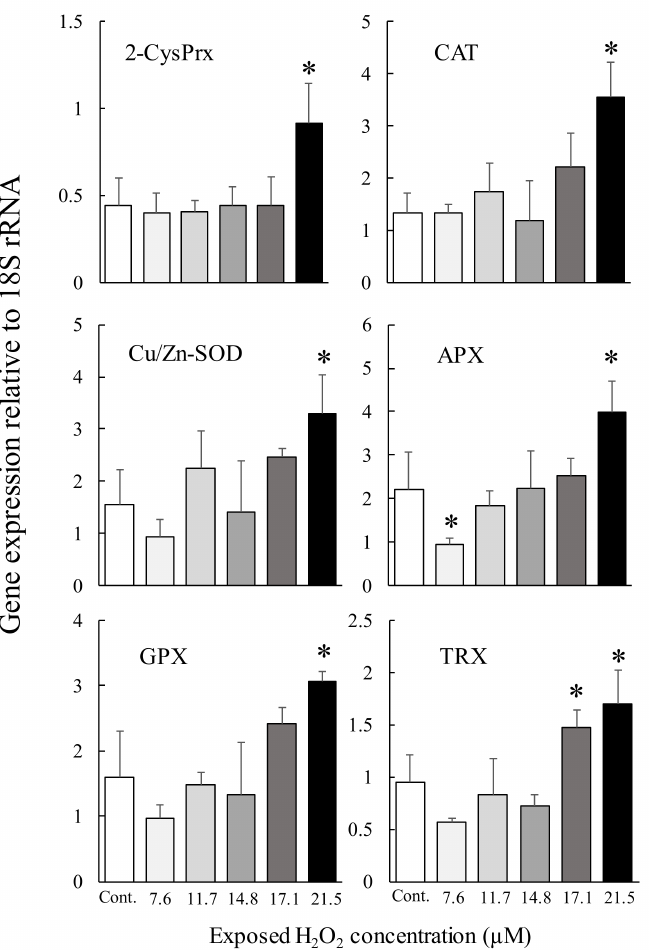
Figure 5. Levels of gene expression of six antioxidant enzymes (2-CysPRX, Cu Zn superoxide dismutase (Cu/Zn-SOD), glutathione peroxidase (GPX), catalase (CAT), ascorbate peroxidase (APX), and thioredoxin (TRX)) determined by quantitative PCR in Chattonella marina after one day of exposure to various concentrations of H 2 O 2 . The H 2 O 2 concentrations on the ordinate of the figure were measured by the method described in Mukai et al. [51]. Values are means ± SD of four replicates. Asterisks indicate significant differences in expression levels compared with control ( p < 0.05 by Dunnett’s